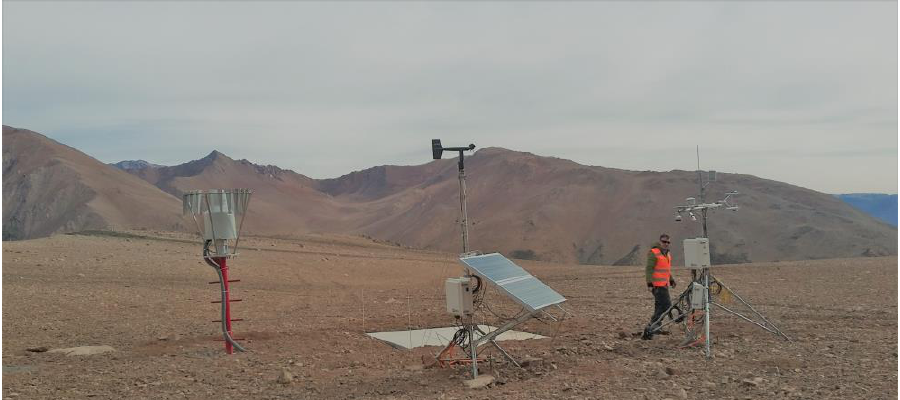
Figure 2. La Ollita meteorological station and the snow scale, on 15 December, 2015 (photo by Miguel Lagos).